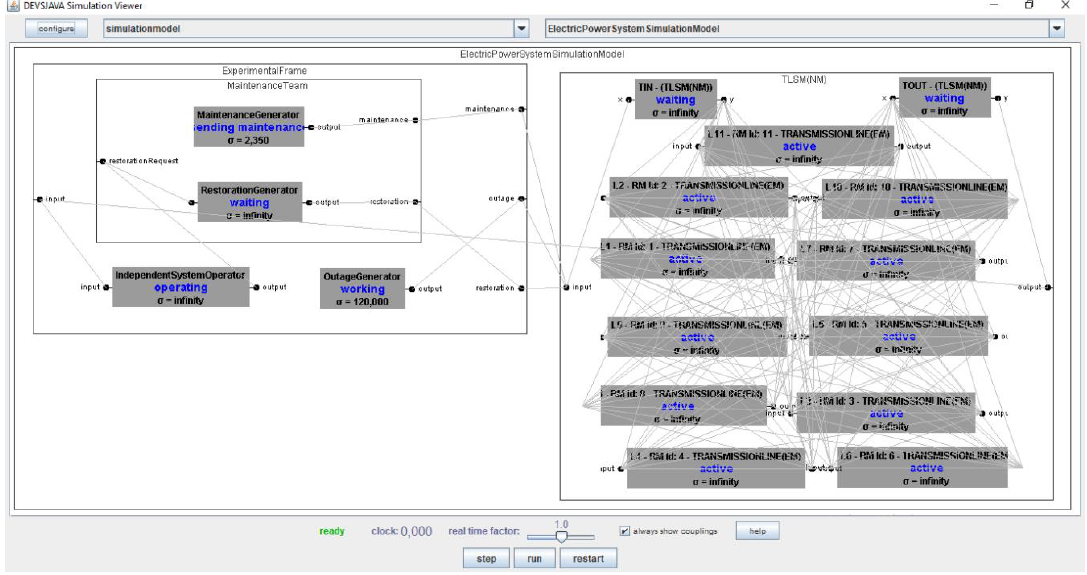
Figure 3. Screenshot of the simulation viewer when simulating the scenario depicted in Figure 171 | Vol. 7, No. 2, 2022